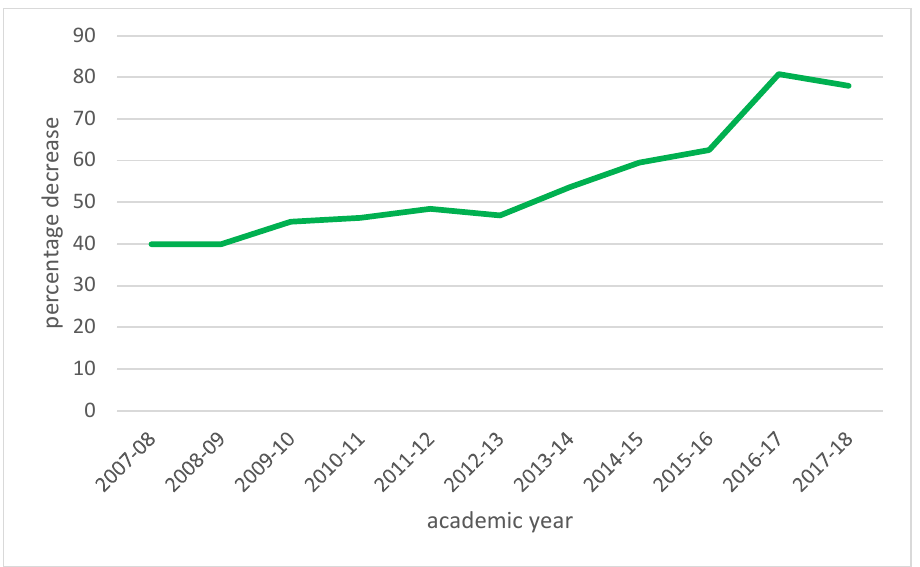
Figure 1. Total cards percentage decrease during the ten years. Source: Own elaboration. To appreciate this decrease, we introduce three ratios in the total matches played: ratio of yellow cards; ratio of red cards and ratio of total cards (by addition of yellow and red cards for each academic year. These ratios are shown in Table 5. Table 5. Evolution of the ratios of cards shown in the ten academic years analyzed, and ratios con- cerning the previous season.